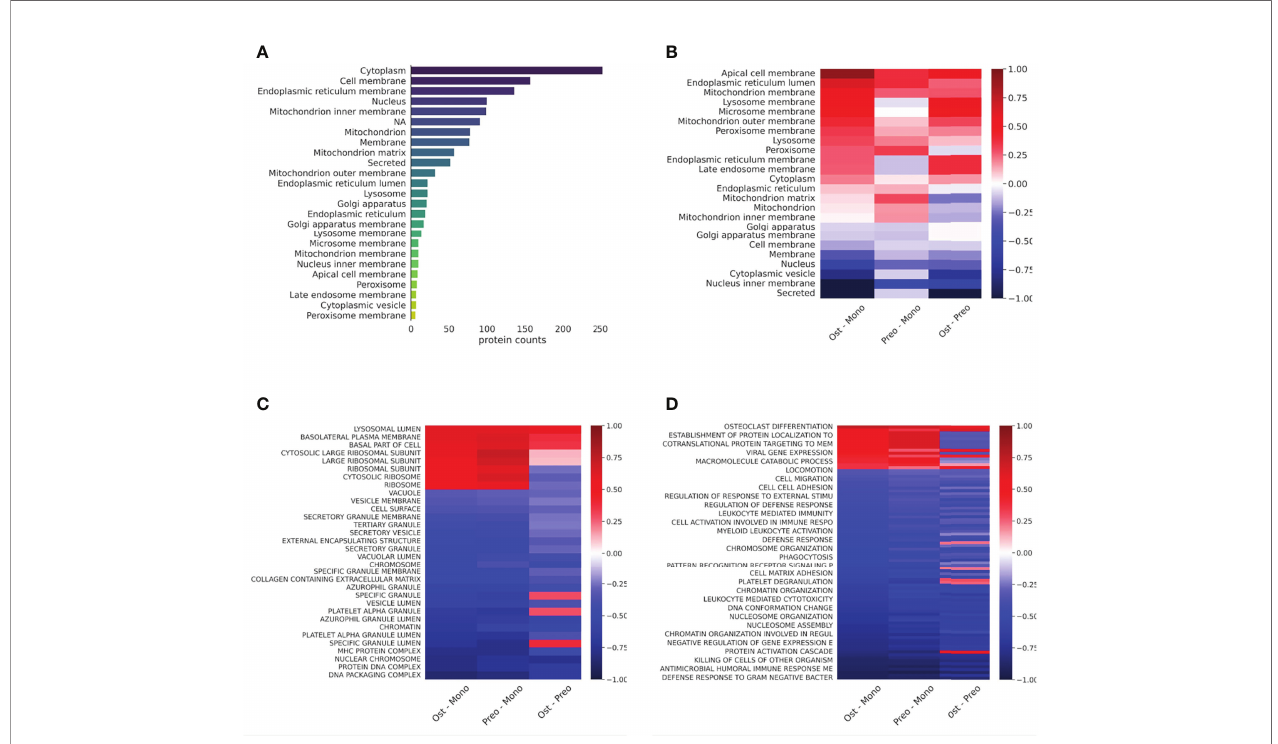
FIGURE 3 | Protein distribution diverge in cell types in case of cellular location and protein expression in case of cell function. (A) : Bar graph representing the protein counts with different cellular locations. (B) : Heat map representing the protein expression differences of cell types in cellular location according to the Uniprot database. Average log2 differential expression data of all proteins localizing to given compartments were compared to overall average differential expression. (C) : Heat map representing the sample protein localizations, analyzed with GSE using GO: Cellular Compartments terms. (D) : Heat map representing the sample protein functions, analyzed with protein GSE using GO: Biological Process terms. For (C) and (D) , terms with the smallest adjusted p-values are shown on the heat- maps. Not all terms are indicated on the y-axis, the full table with p values are provided in Supplementary Table 3